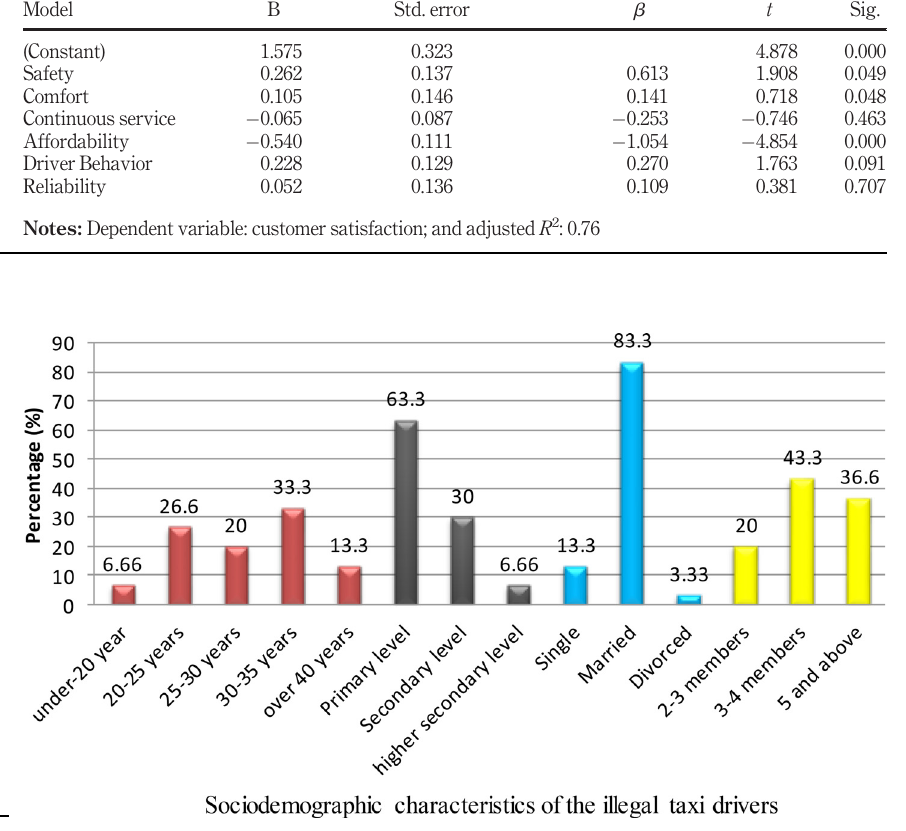
Figure 9. Socio-demographic characteristics of the illegal E-taxi